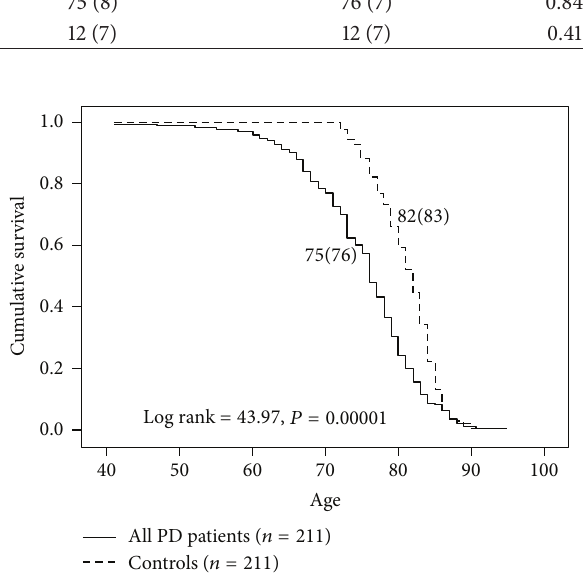
Figure 1: Survival analysis of all PD patients versus age-, gender-, and race-matched controls from the U.S. population. Controls had a seven-year longer survival on average relative to PD patients.